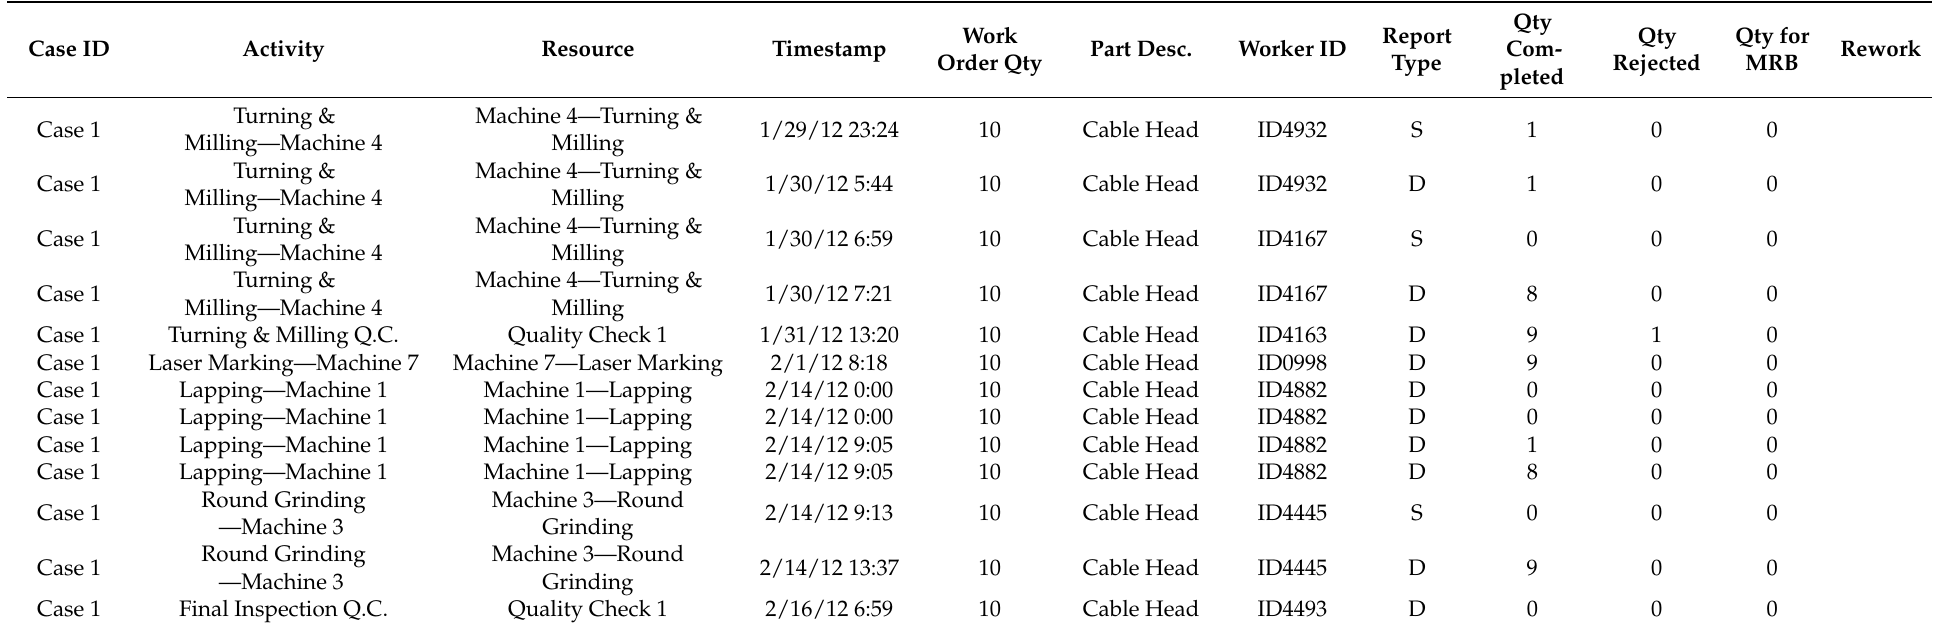
Table 6. Fragment of event log from manufacturing